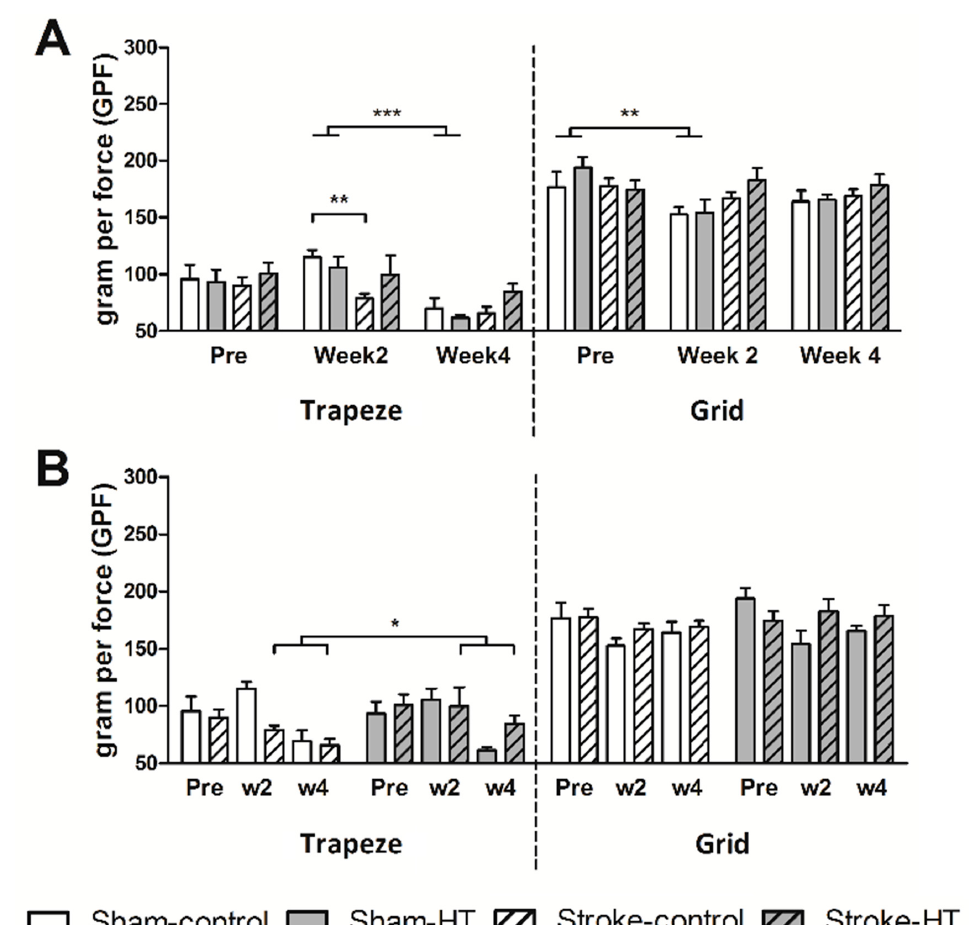
Figure 5. Grip strength in the forelimbs (trapeze) and in all four paws (grid) before (pre) and after (weeks 2 and 4) stroke. ( A ) Time effects and (B) diet effects on maximum grip strength are shown. ( A )